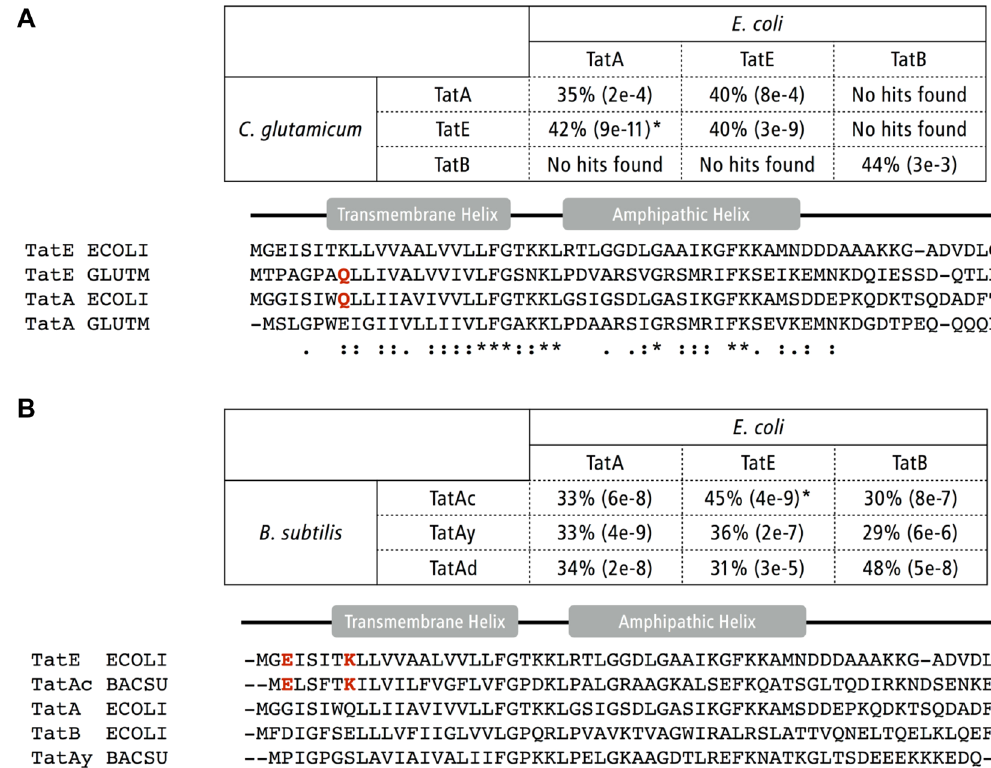
Figure 5. TatE paralogs in Gram-positive bacteria. The degree of sequence similarity, indicated by the percent of identity and the expect e-value (which decreases with the lower chance of random match) between Tat proteins from Escherichia coli and Corynebacterium glutamicum ( A ) and Bacillus subtilis ( B ), respectively, were calculated using NCBI BLAST (upper panels). ( A ) The closest homologue of C. glutamicum TatE is TatA from E. coli , both featuring non-charged N-termini as revealed in the multiple sequence alignment (lower panel). ( B ) In B. subtilis , TatAc is most similar to TatE of E coli , as shown by the common ExxxxK motif. Sequence source: C. glutamicum TatA (Q8NQE4), TatE (Q2MGW8), TatB (Q8NRD0); B. subtilis TatAy (O05522), TatAc (O31804), TatAd